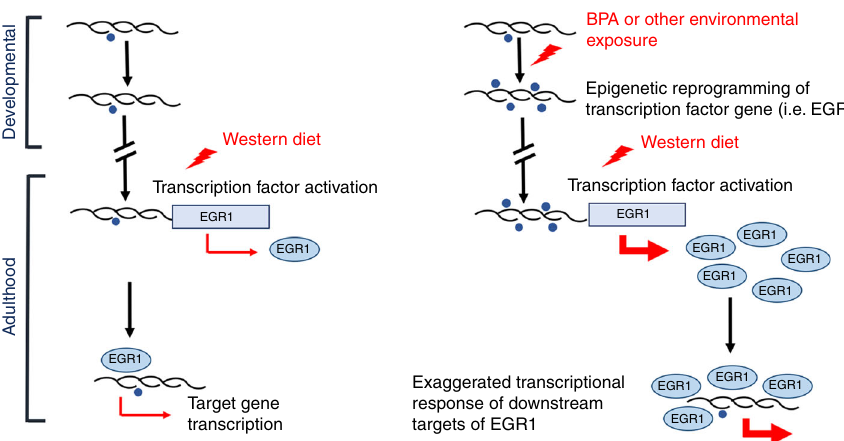
Fig. 5 Model for developmental reprogramming of Egr1 by early-life EDC exposure. Schematic illustrating programming of Egr1 during normal development (left) and reprogramming of Egr1 by early-life EDC exposure (right). Reprogramming may remain transcriptionally and phenotypically silent until triggered by a later life event, such as a dietary